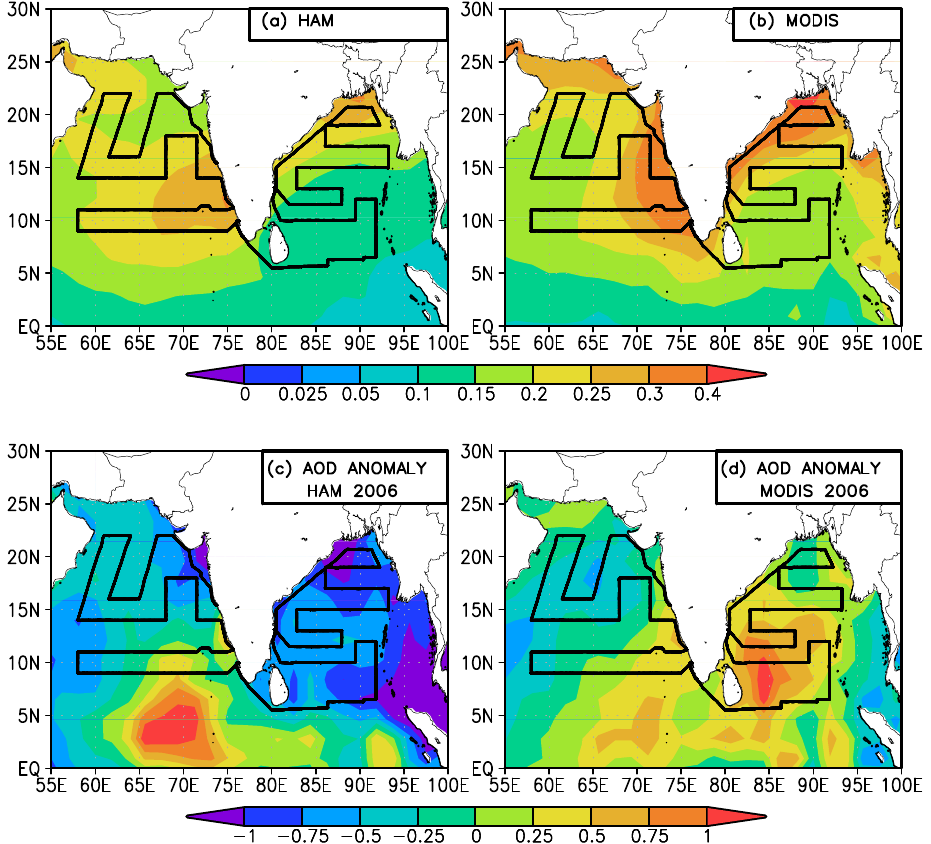
Fig. 3. AOD distributions at 550 nm wavelength (a) as simulated by ECHAM5.5-HAM and (b) as retrieved by the MODIS satellite sensors (Terra and Aqua combined), averaged for 6yr (2001 to 2006) during 18 March to 10 May. Normalized anomaly of (c)